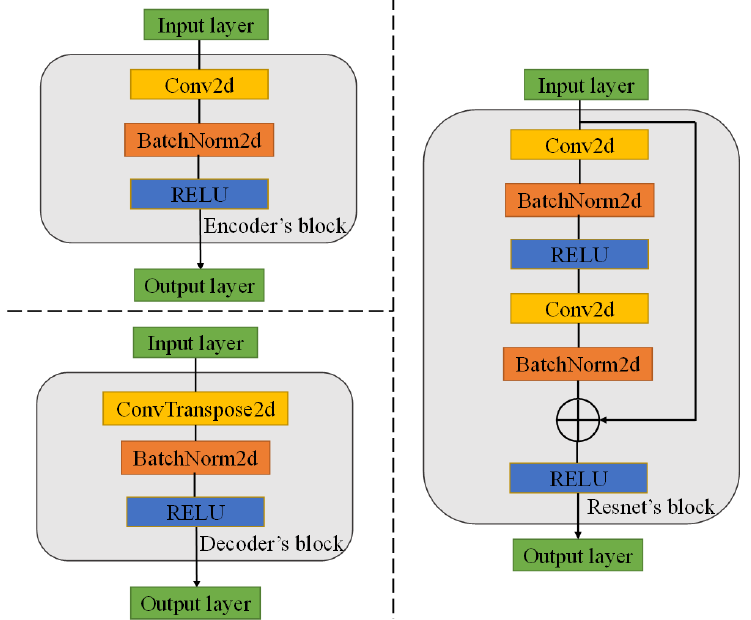
Figure A1. The specific structure of “Encoder-Resnet-Decoder”. The structure of the local discriminator is described in detail in the text. Only the structure of the global discriminator is described in Figure A2. Each block in the figure represents “Conv2d-Activate layer-Norm layer”.